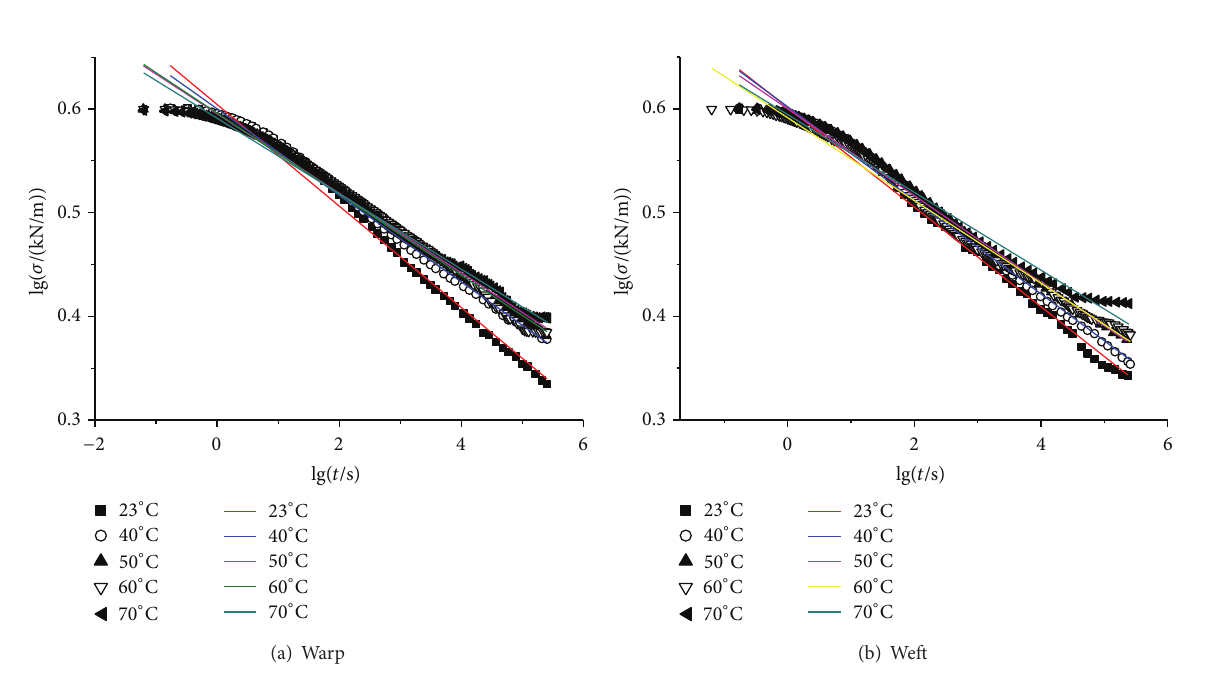
Figure 12: Prediction of the fractional Maxwell model.